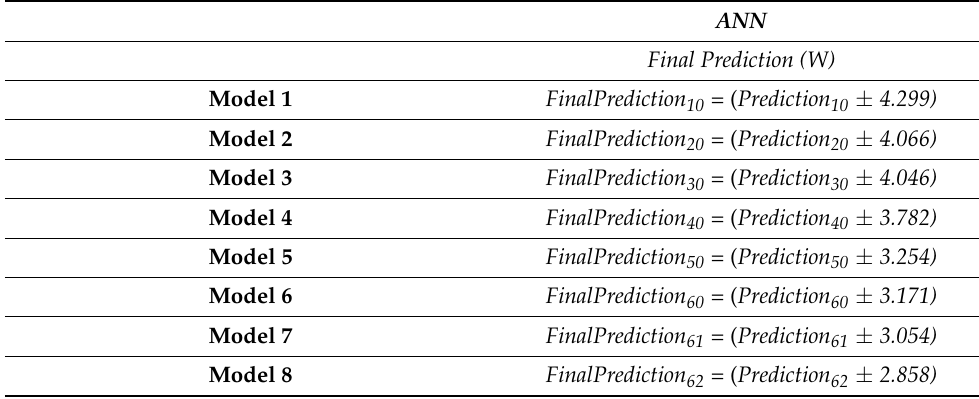
Table 10. Final prediction equations for Models